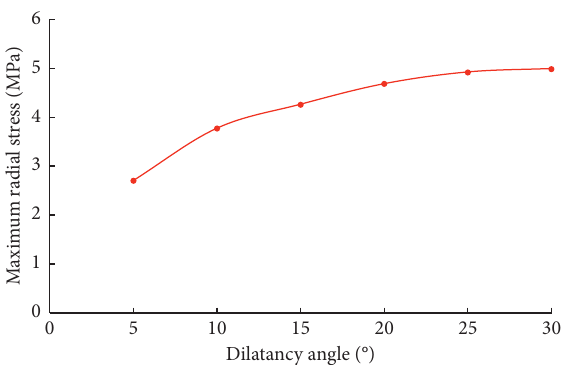
Figure 17: Maximum radial stress at the interface under different dilatancy